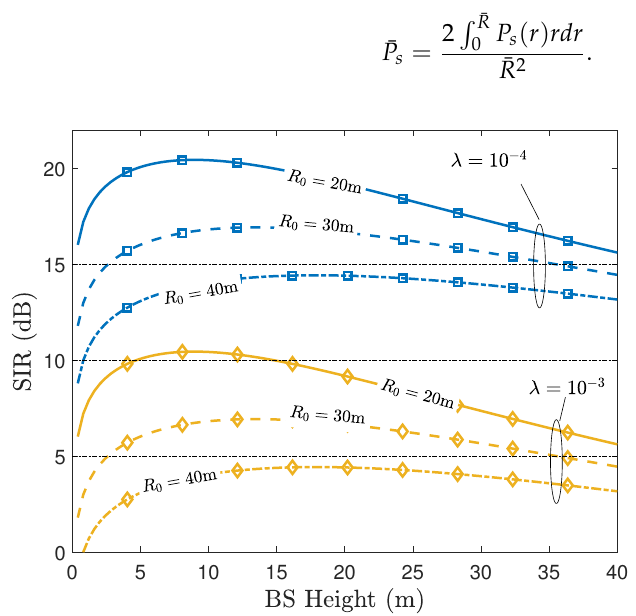
Figure 5. SIR vs. AP height h , for a target UE located at R 0 = { 20,30,40 } m equipped with a uniform circular array (UCA) with N c = 128 that has average power gain ¯ G 2 c = 0.012, for two sets of interfere density λ = { 10 − 4 ,10 − 3 } m − 2 . Parameters: path-loss exponent 2 b = 2.4, normalized amplitude | β o | = 1, R max → ∞